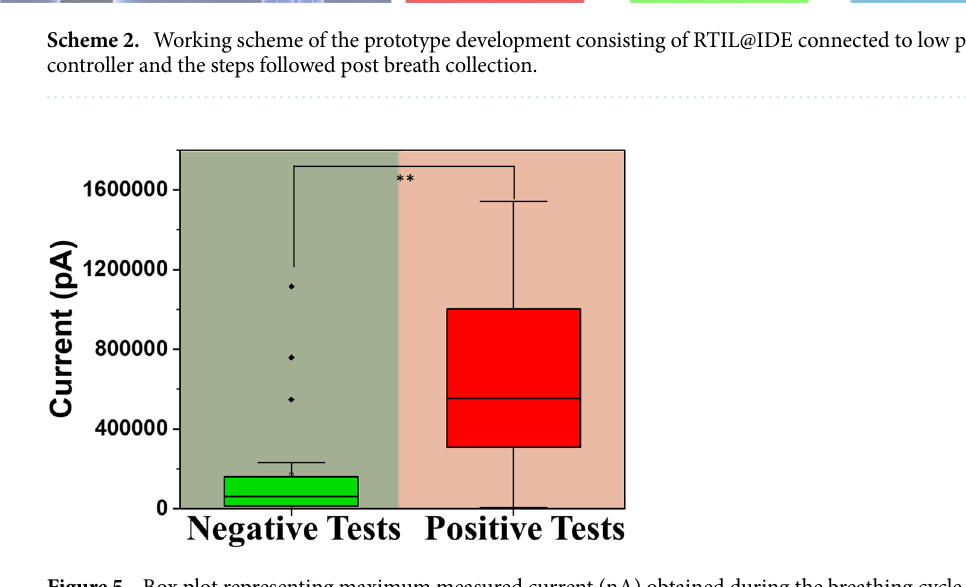
Figure 5. Box plot representing maximum measured current (nA) obtained during the breathing cycle as obtained using the device for both the positive and negative